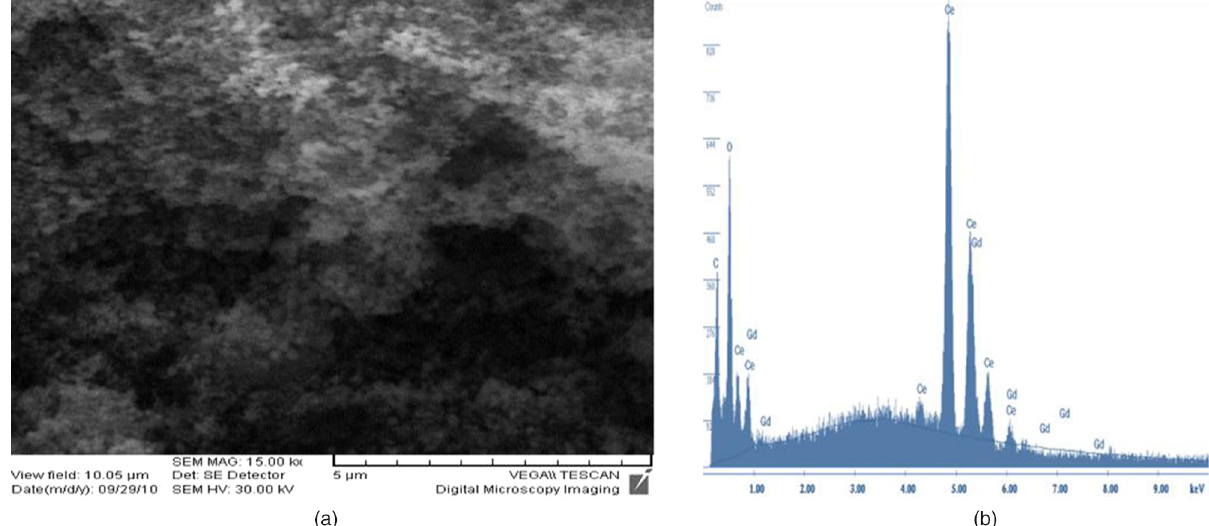
Fig. 2. (a) SEM micrograph of nano-SPVD powders of CeO 2 doped with Gd. (b) EDX spectrum of nano-SPVD powders of CeO 2 doped with Gd.